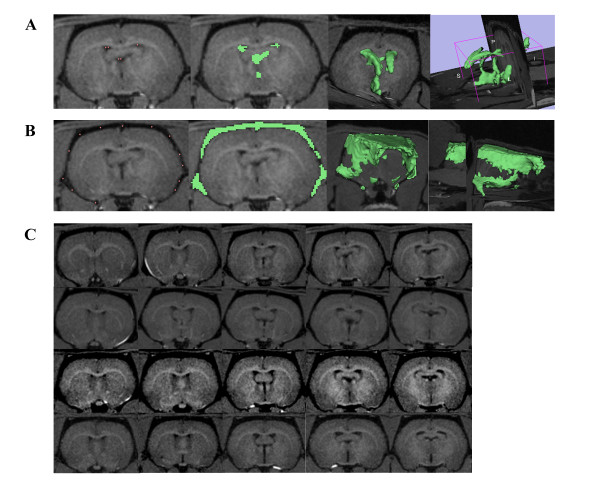
Total CSF volume. A) CSF in the ventricles was measured by placing fiducial points (pink dots) on black pixels within the region of interest. FastMarching Segmentation in Slicer 3D generates a rough sketch of the region of interest (green areas), as well as a 3D model. Volume is calculated from this model. B) Similar steps were taken to measure CSF in the subarachnoid space. All measurements were done by one reader for consistency. C) T1-weighted MR images. Each row represents five coronal slices from one rat brain (top row = 3 month, second row = 12 month, third row = 20 month, bottom row = 30 month). Images were magnified and brightened for printing purposes.